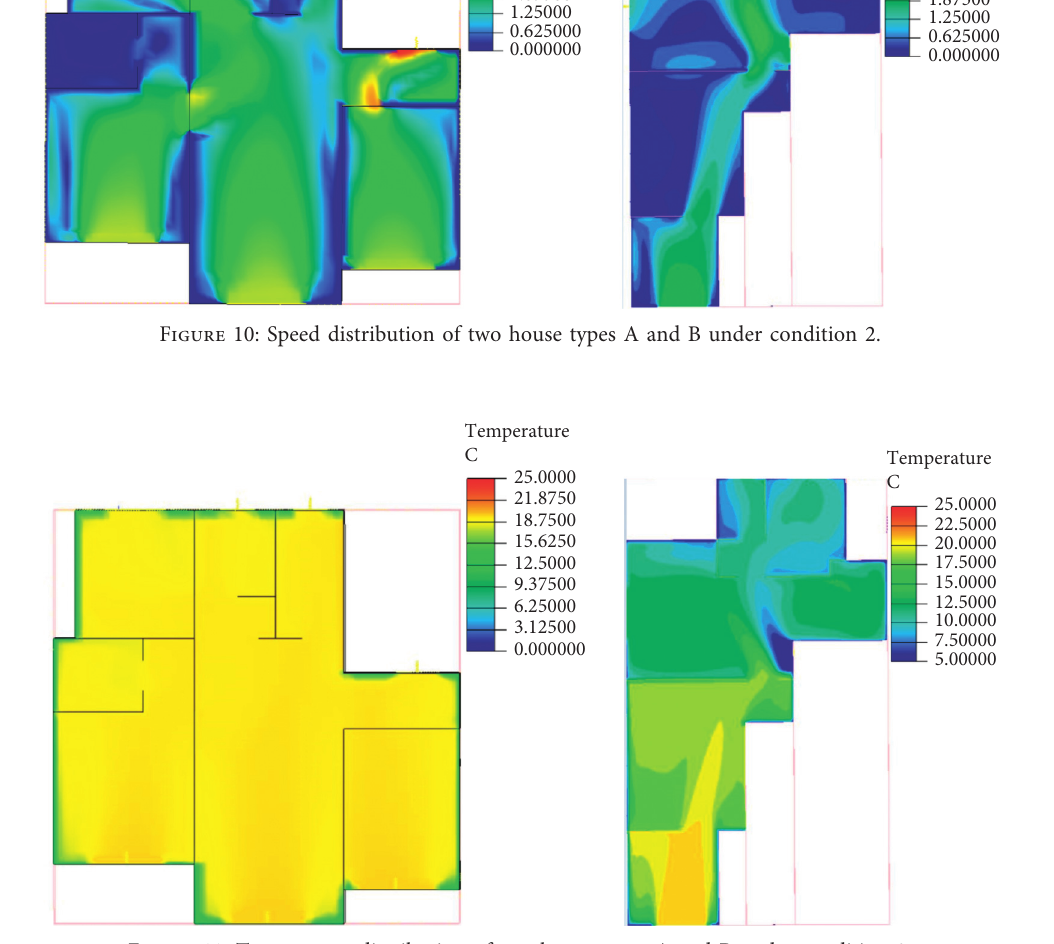
Figure 11: Temperature distribution of two house types A and B under condition 2.